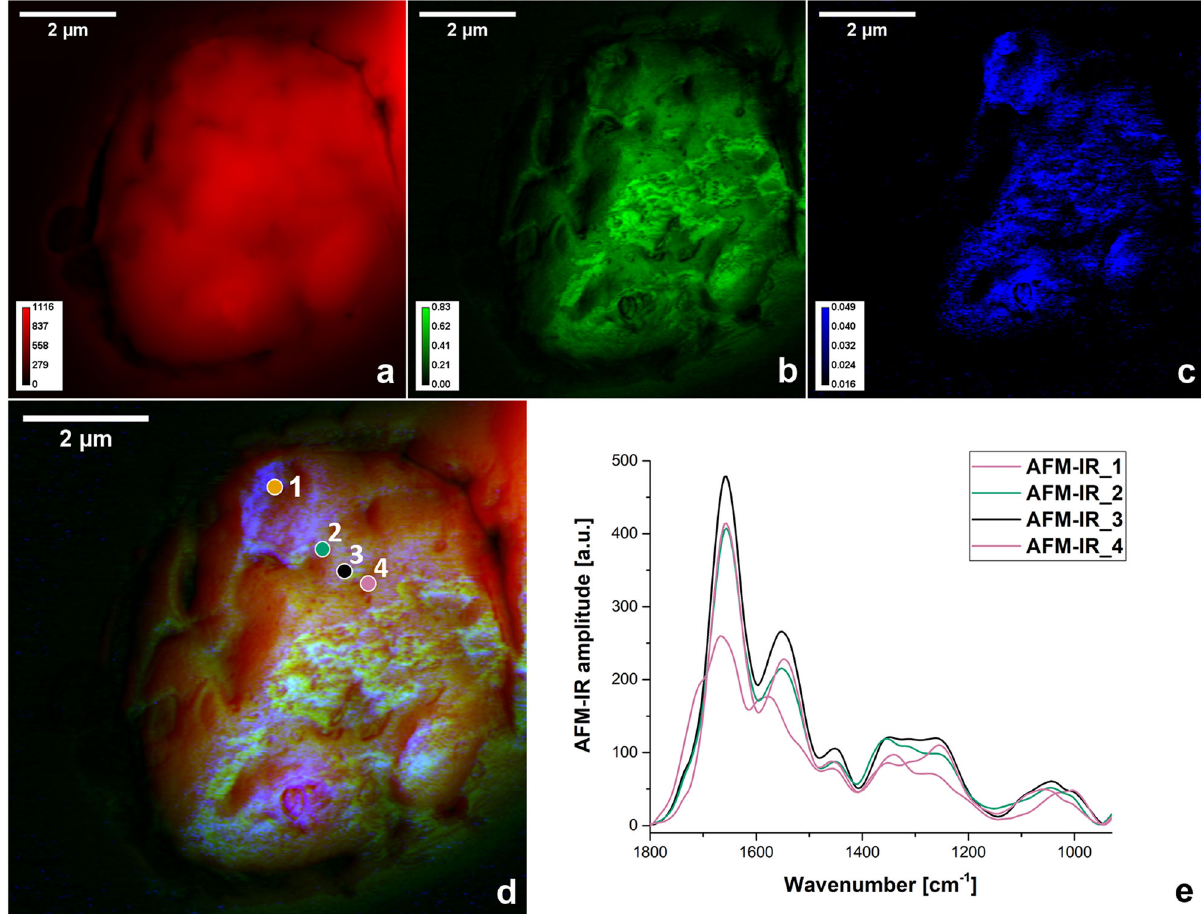
Fig. 5 Analysis of individual infected RBC by AFM-IR spectroscopy. Contact mode AFM height image ( a ), distribution of amide I band ( b ) and stretching vibrations of C = O in lipids ( c ) for selected iRBC. RGB-composite image ( d ), showing the AFM height (red) with distribution of amide I band (green) and stretching vibrations of C = O in lipids (blue). AFM-IR spectra ( e ) collected at points 1-4 marked in the RGB- composite image ( d